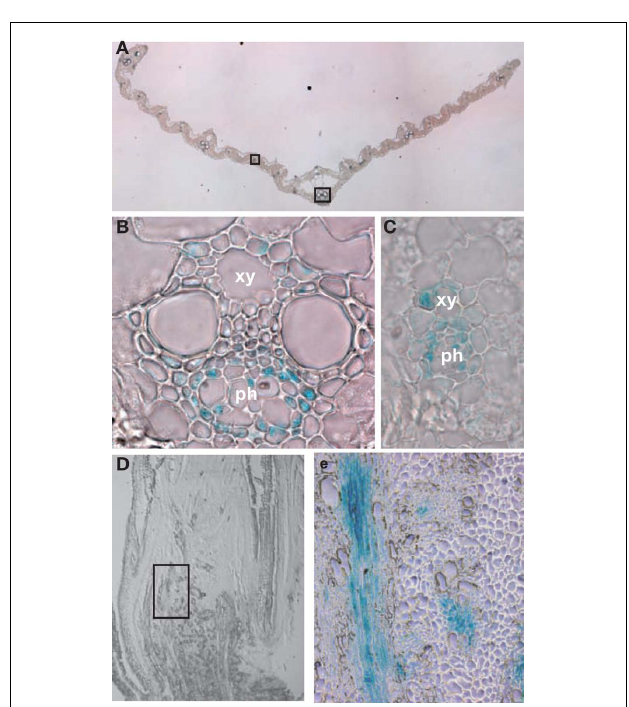
FIGURE 6 | Cell-specific expression of OsNADH-GOGAT 2. An approximately 1.3kb sequence (from − 1302 to + 4) upstream of the ATG start codon (position + 1) of OsNADH-GOGAT 2 was fused with GUS structural gene and this chimeric gene was introduced into wild-type (WT) rice.The transformants atT1 generation were grown for 26days and fully expanded fourth leaf blade were cut into 1mm-thick cross-sections, and then GUS activity was visualized by staining. Longitudinal-sections were also prepared from a basal node area. (A) GUS activity in cross-section of fully expanded leaf blade. (B) Enlarged view of a large vascular bundle. (C) Enlarged view of a small vascular bundle. (D) Longitudinal-sections of a basal node area. (E) Enlarged view of a large vascular bundle and nodal plexus vascular bundle area. ph, phloem element; xy, xylem vessel